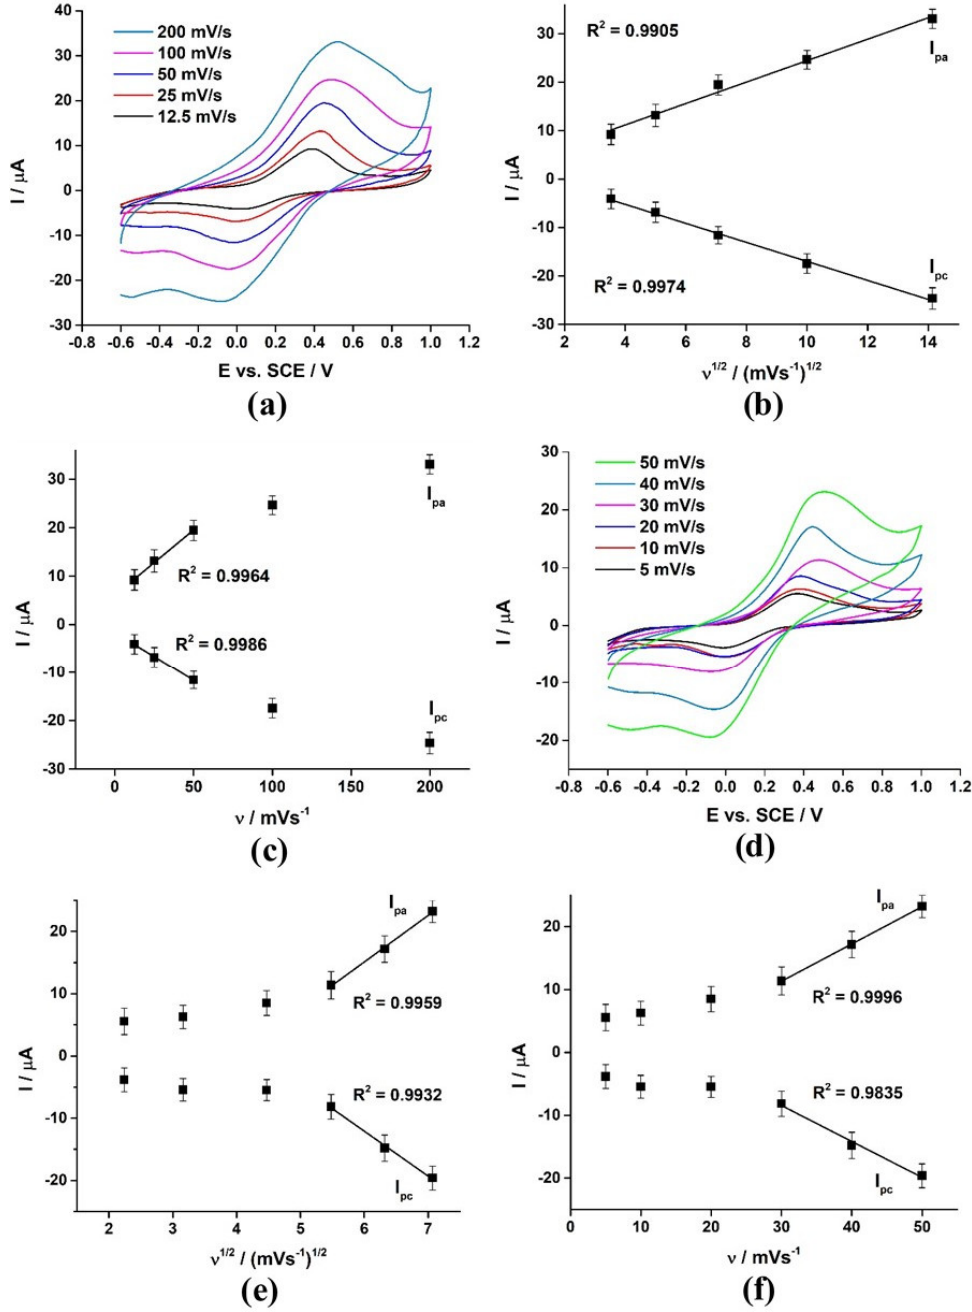
Figure 4. ( a , d ) CV curves at different scan rate ranges, ( b , e ) I vs. v plots, and ( c , f ) I vs. v 1/2 plots. The adsorption of PAni on the electrode surface in the presence of a varying concentration of NO 3− is presented in Figure 5a,b. As already discussed, the amount of ES